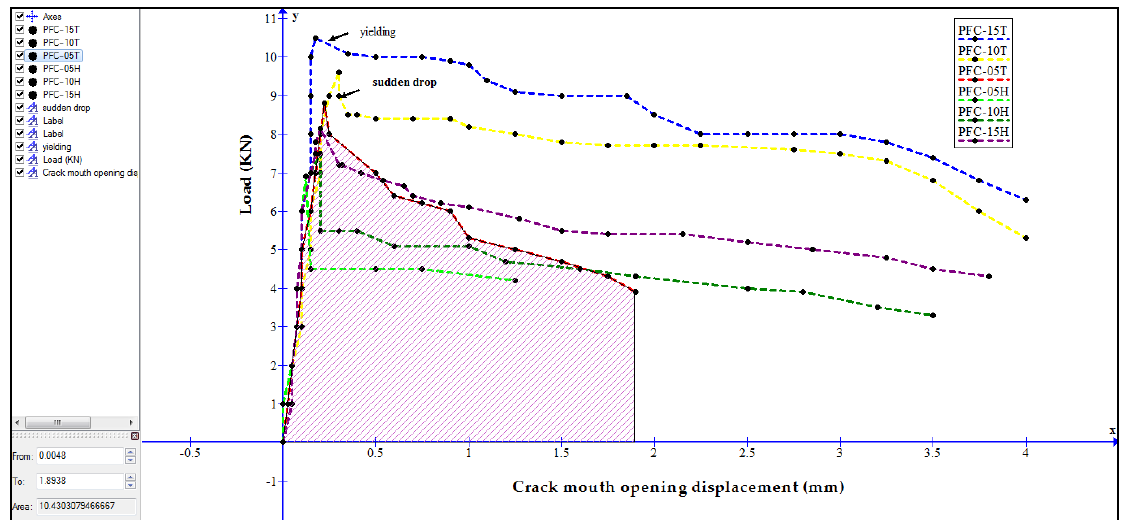
Figure 16. Flexural toughness calculation from load-CMOD plots of various concrete mixes.